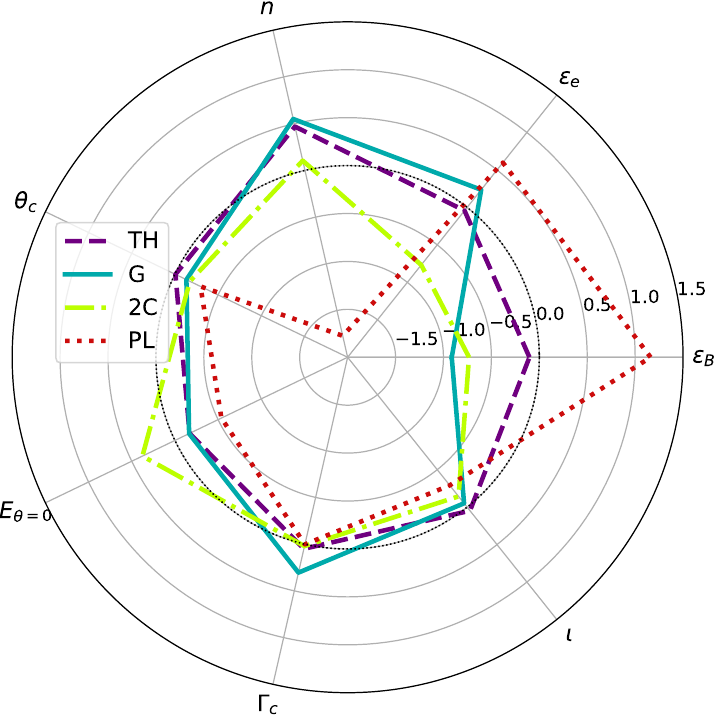
Figure 4. A polar plot showing the log ratio values for each parameter from a fixed jet structure model fit to GRB170817A data via MCMC, without and with lateral spreading. Each parameter distribution’s median and 16th and 84th percentile limits are listed in Table 1 for all models. The radial ( wo/w ) of the central posterior distribution values for the labelled parameters, arm shows the log 10 where wo is without lateral spreading and w is with maximal lateral spreading at the sound speed. An equal ratio of one is indicated with a black dotted line. The top-hat structure is shown in purple with a dashed line, a Gaussian jet structure is shown in aqua with a solid line, a two-component jet is shown in green with a dot-dashed line, and a powerlaw structure is shown in red with a dotted